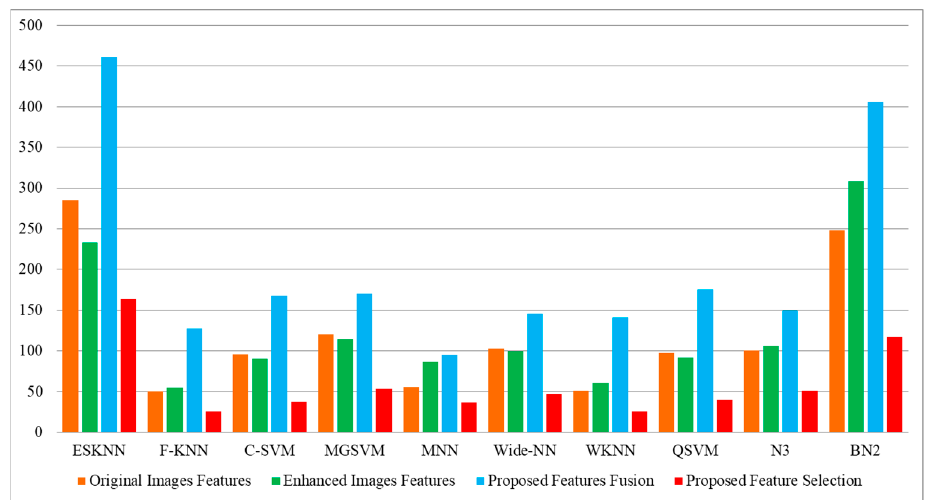
Figure 11. Comparison of proposed feature selection technique in terms of computational time with Tables 2–4.